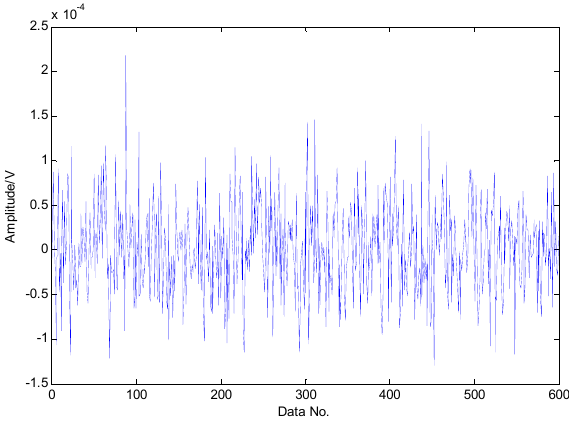
Figure 15. Random sampling of transient impact component through Gaussian random matrix.